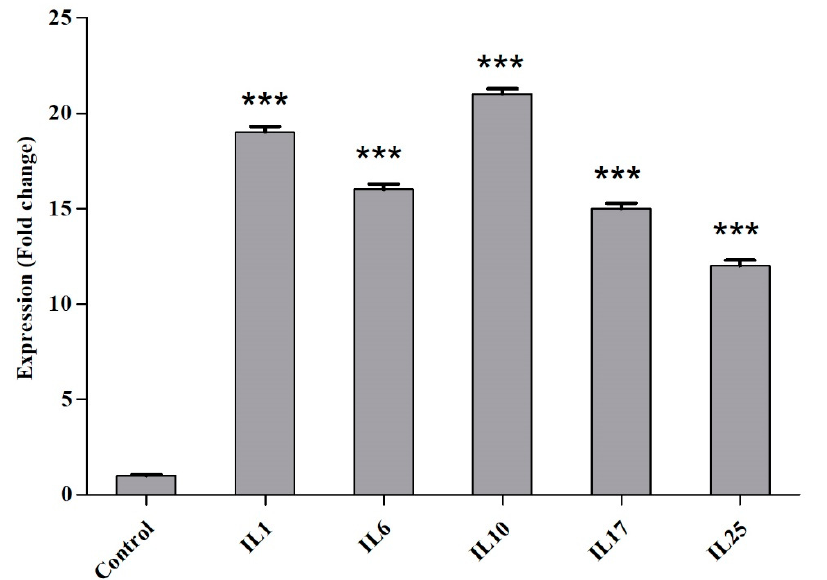
Figure 2. Immune genes expression in COVID-19 patients and control group (*** significantly different than control ( p < 0.05).